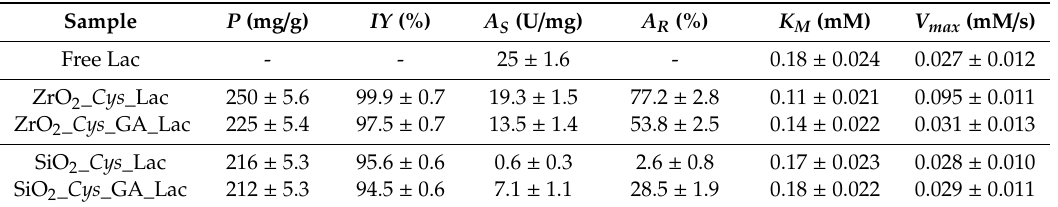
Table 5. Catalytic and kinetic parameters describing the biocatalytic